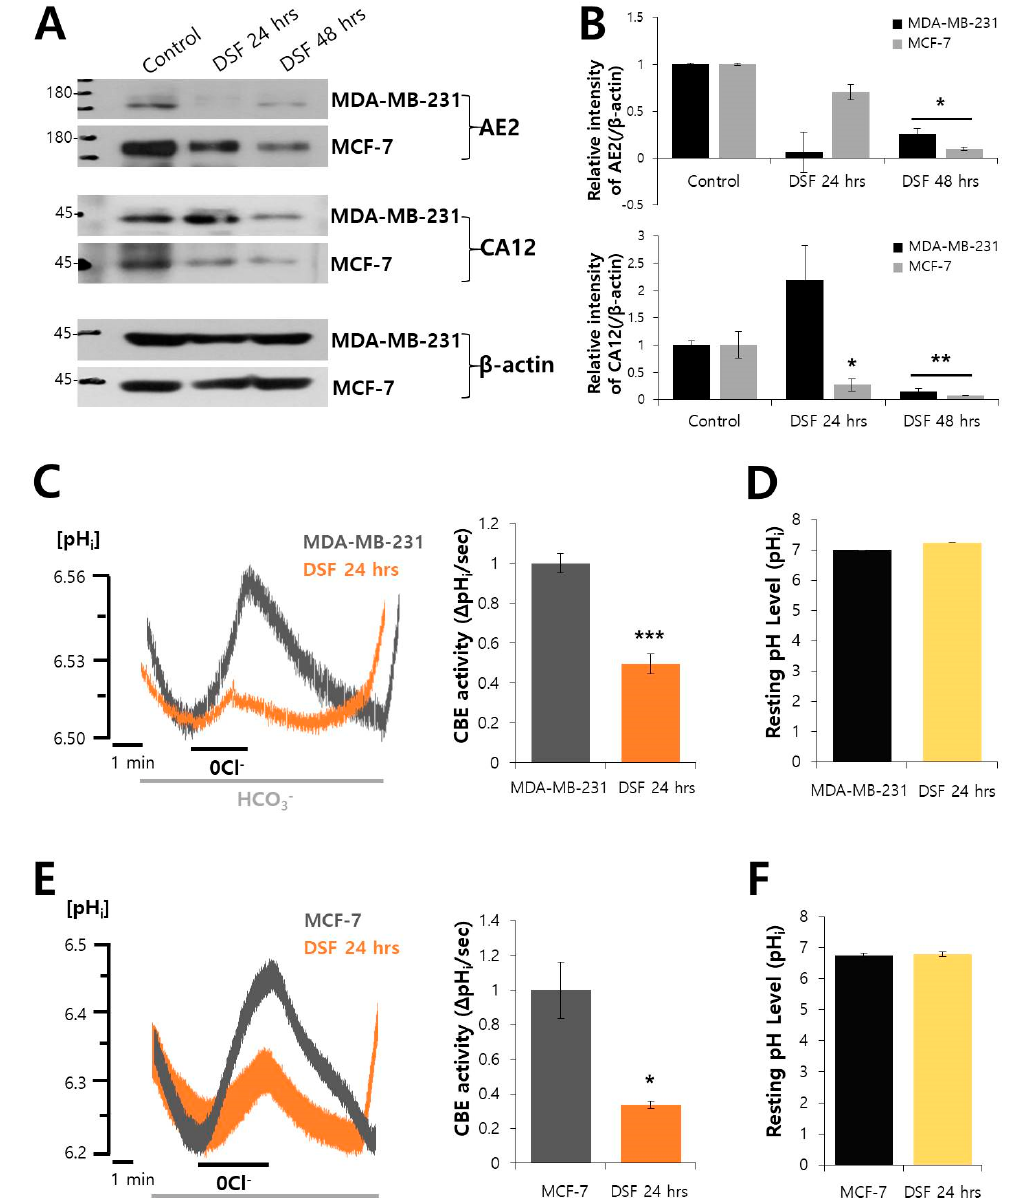
Figure 4. DSF also decreased the expressions of AE2 and CA12 and CBE activity in breast cancer cell lines. ( A ) The protein expressions of AE2 and CA12 with and without treatment of 2 µ M DSF in MDA-MB-231 and MCF-7 cells. The β -actin was used as loading control. ( B ) Analysis of relative intensity of AE2 and CA12 blots in MDA-MB-231 and MCF-7 cells. Bars represent mean ± SEM (n = 3, * p < 0.05, ** p < 0.01). ( C ) CBE activity of MDA-MB-231 cells treated with 2 µ M DSF (yellow trace) at 24 h and the cells not treated with DSF (Control, gray trace). Average traces are represented. The bar graph indicates CBE activity of MDA-MB-231 cells with and without DSF and the means ± SEM (n = 4, *** p < 0.001). ( D ) The bars show resting pH i level of MDA-MB-231 cells which indicate the means ± SEM. ( E ) CBE activity of MCF-7 cells treated with 2 µ M DSF (yellow trace) at 24 h and the cells not treated with DSF (Control, gray trace). Average traces are represented. The bar graph indicates CBE activity of MCF-7 cells with and without DSF and the means ± SEM (n = 4, * p < 0.05). ( F ) The bars show resting pH i level of MCF-7 cells which indicate the means ±